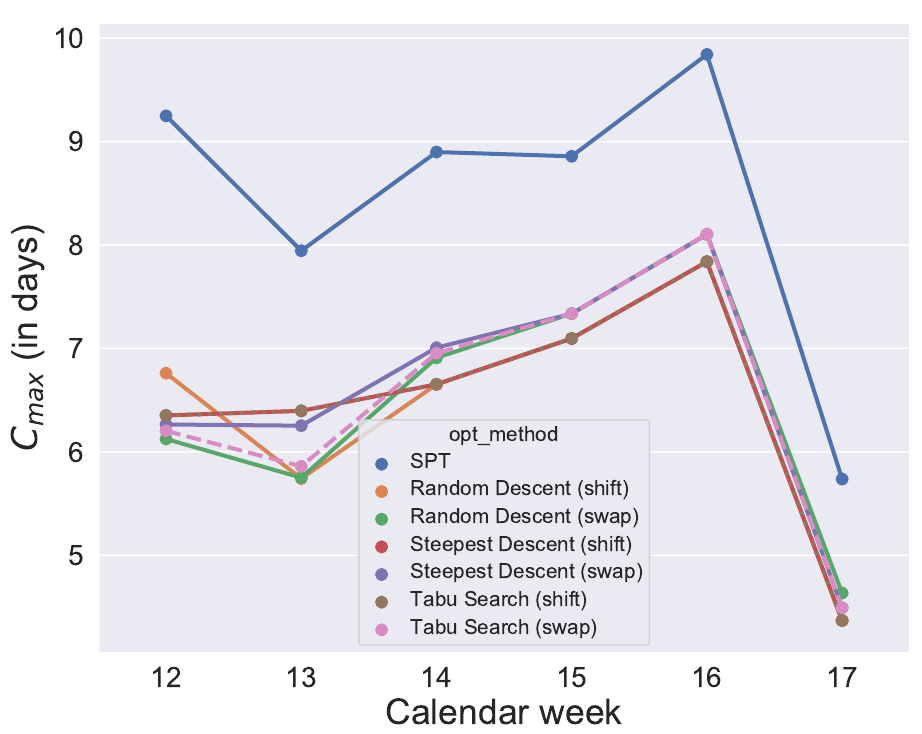
Figure 9. Optimization results for quantile